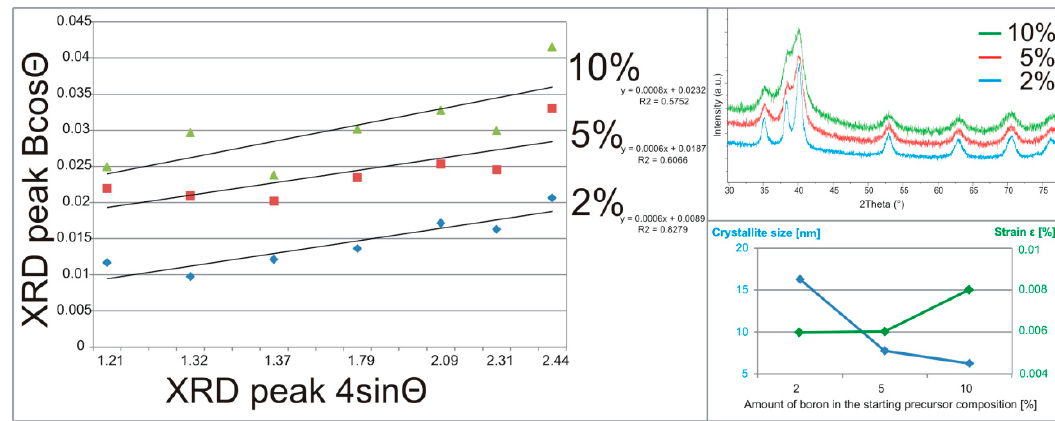
Figure 5. The crystallite size and the strain estimation based on the Willamson–Hall Uniform Deformation Model approach, realized on the XRD spectra of the obtained (after 48 h) mechanically alloyed precursor compositions with their linear plot course.